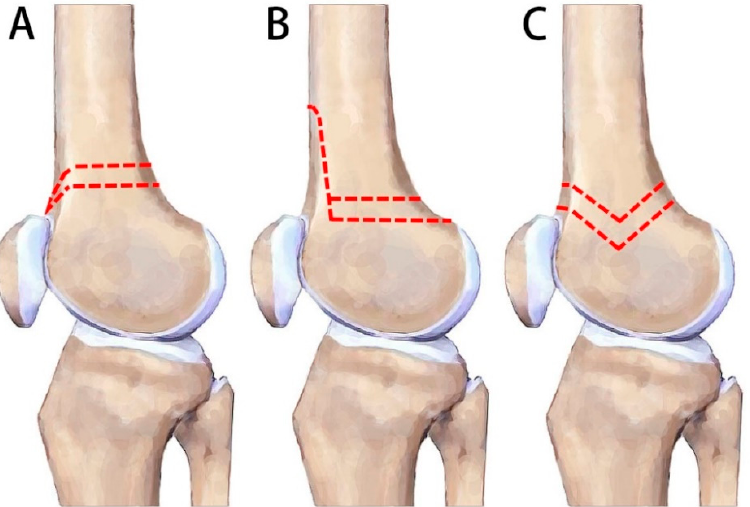
Figure 5. A comparison of DFO techniques. ( A ) Uniplanar technique. ( B ) The “three-cut” biplanar technique. ( C ) The “four-cut” double chevron-cut technique. Note that the distal-most possible site of the biplanar is farther than in the uniplanar technique, since it avoids the femoral trochlea. The double chevron-cut technique may be performed even more distally, since it also avoids the posterior condyle of the femur.